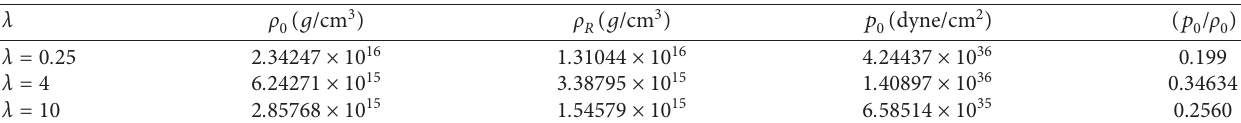
Table 2: The determined numerical values of central density, surface density, and central pressure for different values of λ . Here, we choose λ � 0 . 25 , 4 ,